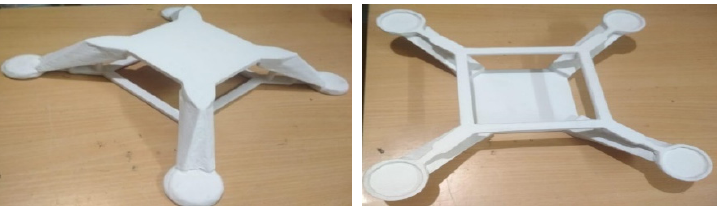
Figure 12. 3D printed structure.